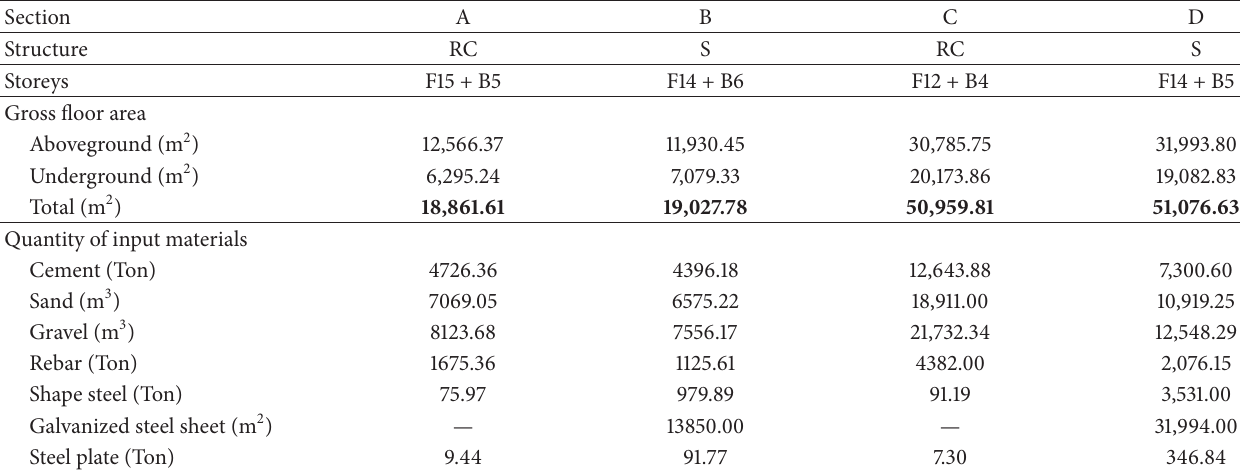
Table 1: Case study buildings: summary of input materials.